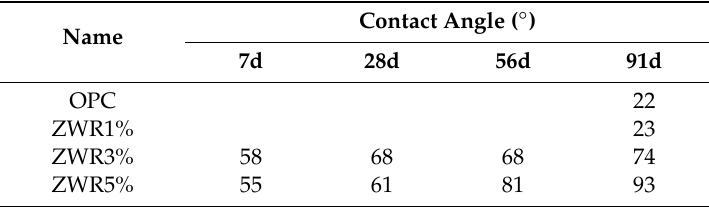
Figure 12. Graph of contact angle measurement with curing time. Table 10. Result of contact angle test.